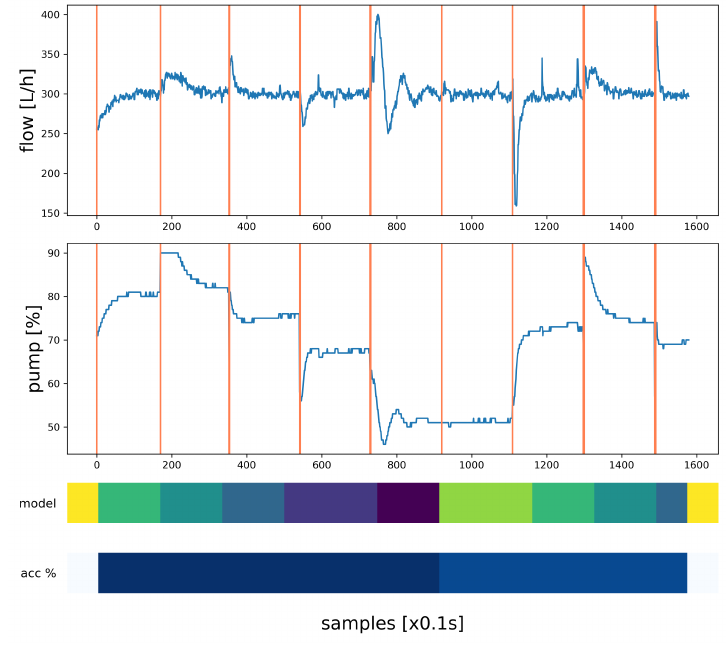
Figure 11. Control integration